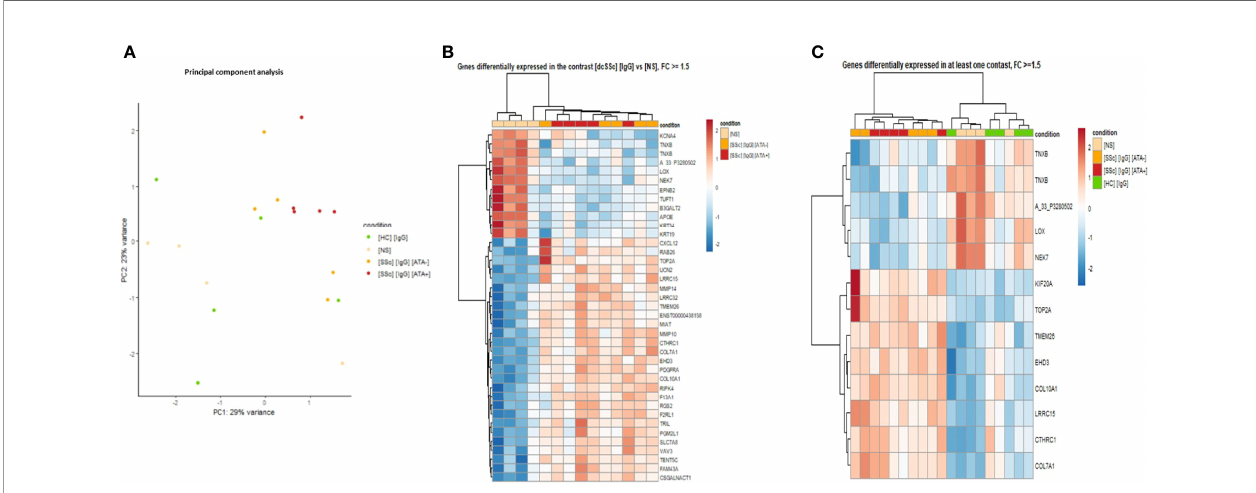
FIGURE 4 | Transcriptomics identi fi ed FB ECM remodeling changes induced by dcSSc-puri fi ed IgG. (A) PCA representing the 629 DNA probes (transcriptomics) dysregulated in proteomic analysis highlights genes expression by the FB according to SSc serotype. Puri fi ed IgG from ATA+ patients induced a singular gene expression pro fi le compared to ATA − SSc patients and HC; (B) Heatmap representing genes dysregulated in the contrast [dcSSc] [IgG] vs [NS] with FC >1.5; (C) Heatmap representing top-ranked genes dysregulated with FC >1.5. FC, fold change; [dcSSc] [IgG], IgG from dcSSc (anti-topoisomerase-I positive and anti- topoisomerase-I negative patients); [SSc] [IgG] [ATA+], IgG from dcSSc anti-topoisomerase-I positive patients; [SSc] [IgG]; [ATA − ], IgG from dcSSc anti- topoisomerase-I negative patients; [NS], non stimulated fi broblasts; [HC] [IgG], IgG from healthy